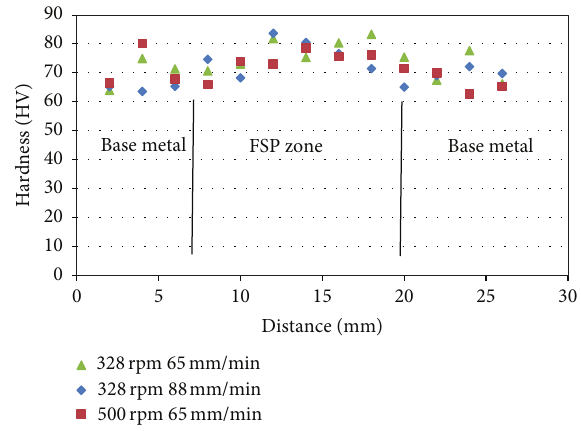
Figure 20: Microhardness test results for the FSP